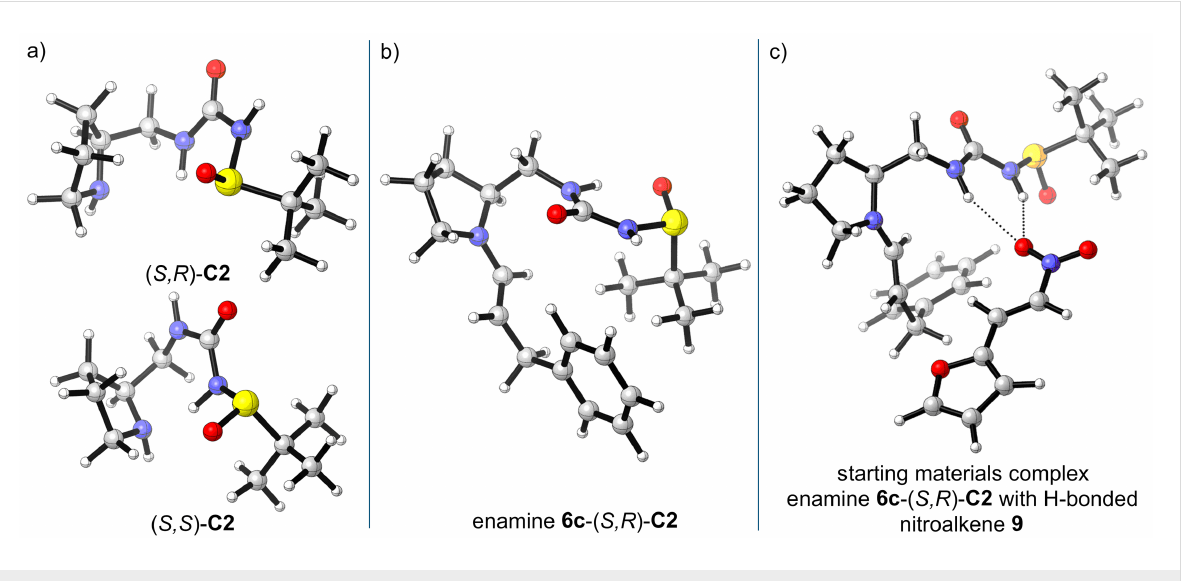
Figure 2: DFT-calculated (PBEh-3c/def2-SV(P)//M06-2X/def2-TZVP) structures of catalyst ( S,R ) and ( S,S )- C2 , enamine between aldehyde 6c and ( S,R )- C2 ; enamine 6c -( S,R )- C2 and hydrogen-bonded nitroalkene 9